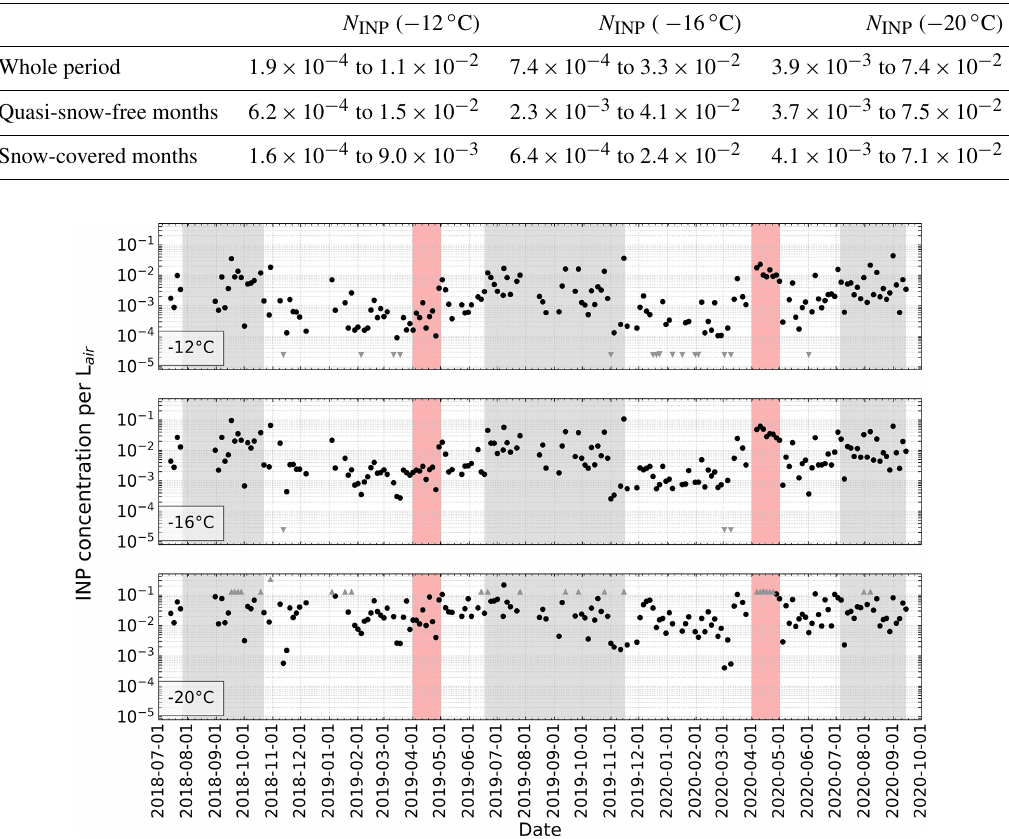
Figure 1. Time series of N INP at − 12, − 16 and − 20 ◦ C. Circles represent measured INP concentrations, while upward and downward pointing triangles indicate that samples have INP concentrations above or below the detectable range, respectively. Note that the detection limit varies depending on the air volume sampled on the filter. The gray areas show periods when snow depth measured at Villum Research Station (VRS) was below 0 . 8m. The red areas indicate April 2019 and 2020, which are later compared in a case study.